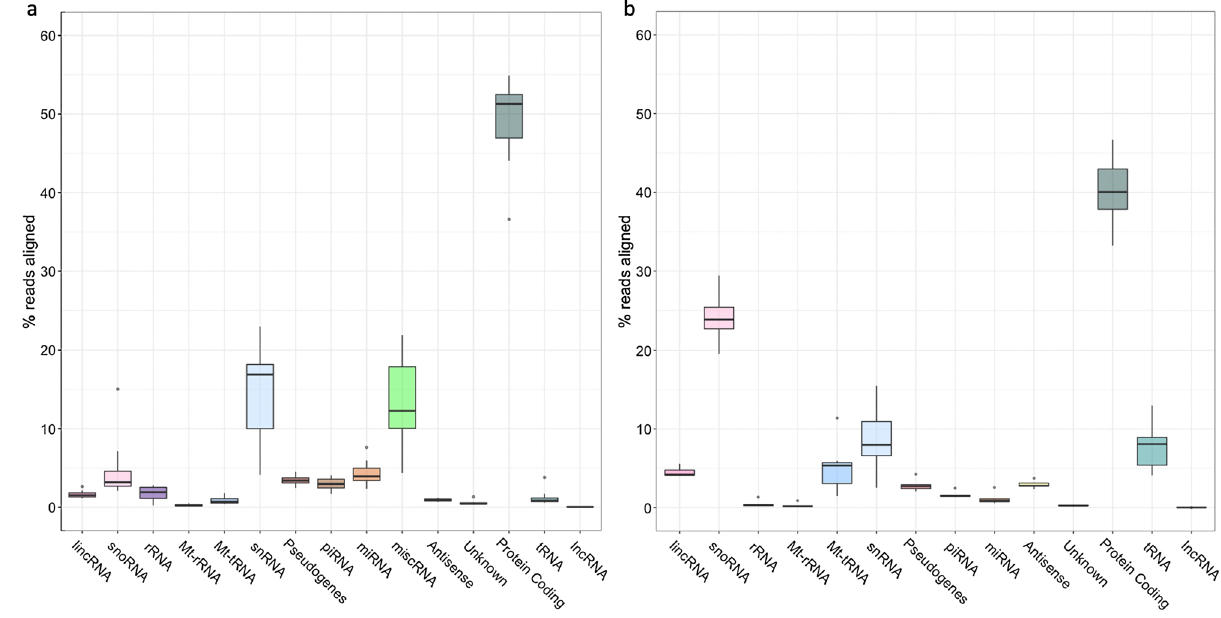
Figure 4. Box and whisker plot showing the range of percentages of reads mapped to gene biotypes for ( a ) mouse and ( b ) human samples. The majority of RNA species in both samples show very small ranges, while some (notably snRNA and snoRNA) are more variable between